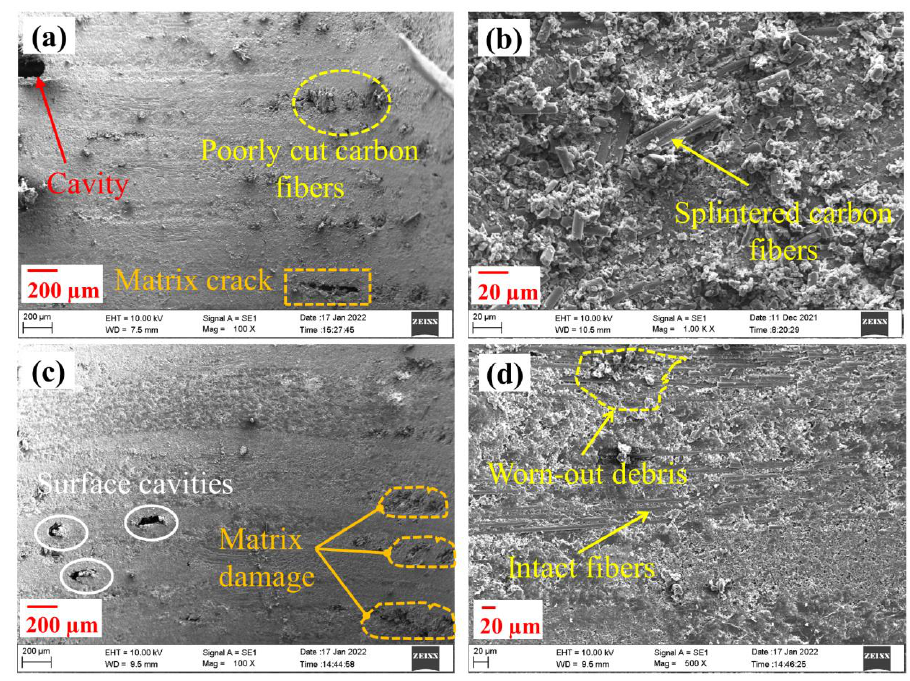
Figure 8. Morphology of neat CEC drilled at ( a – c ) A = 1000 rpm, B = 0.07 mm.rev −1 , C = 4 mm; ( d – f ) A = 3250 rpm, B = 0.05 mm.rev −1 , C = 6 mm; and ( g – i ) A = 3250 rpm, B = 0.05 mm.rev −1 , C = 8 mm.